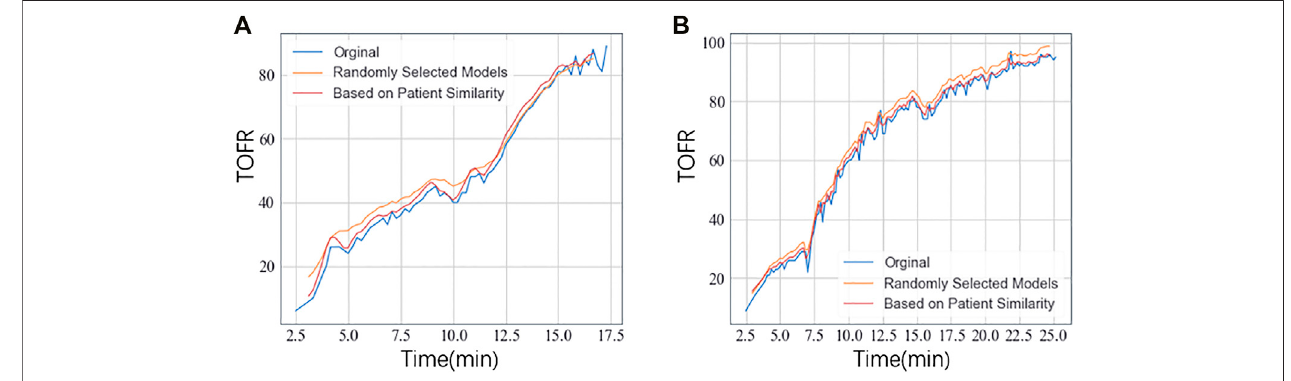
FIGURE 3 | The TOFR curves of two patients (A,B) based on transfer learning. GRU model was